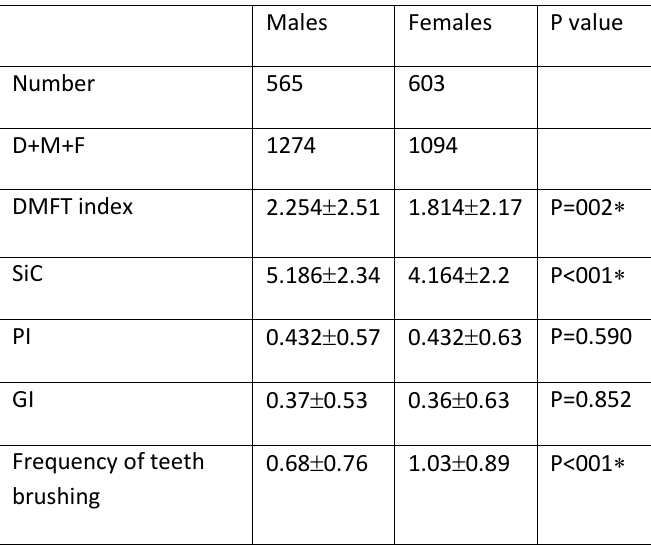
Table 3: Gender variations (Independent samples